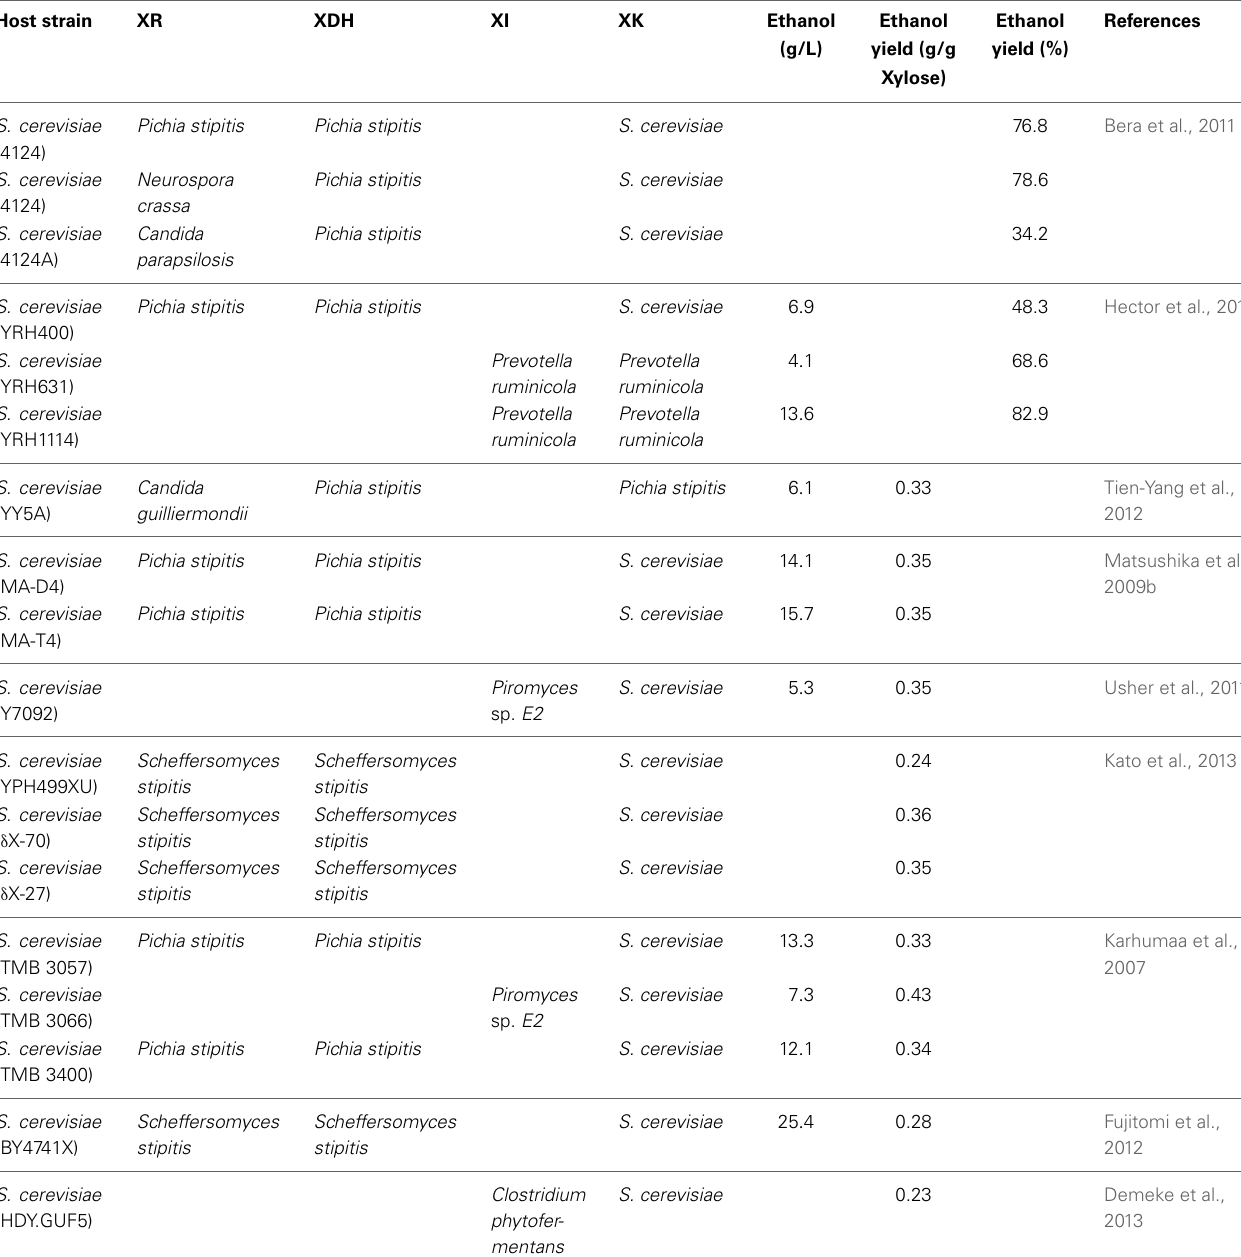
Table 2 | Ethanol production from xylose by recombinant yeast strains expressing xylose utilizing